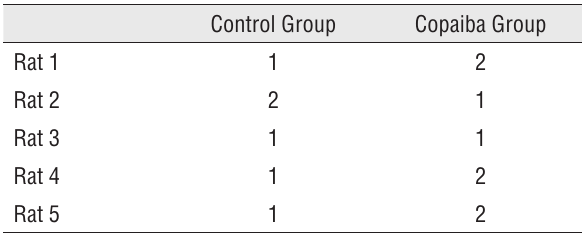
Table 2 - Categories of adhesion according the Nair score in both groups.